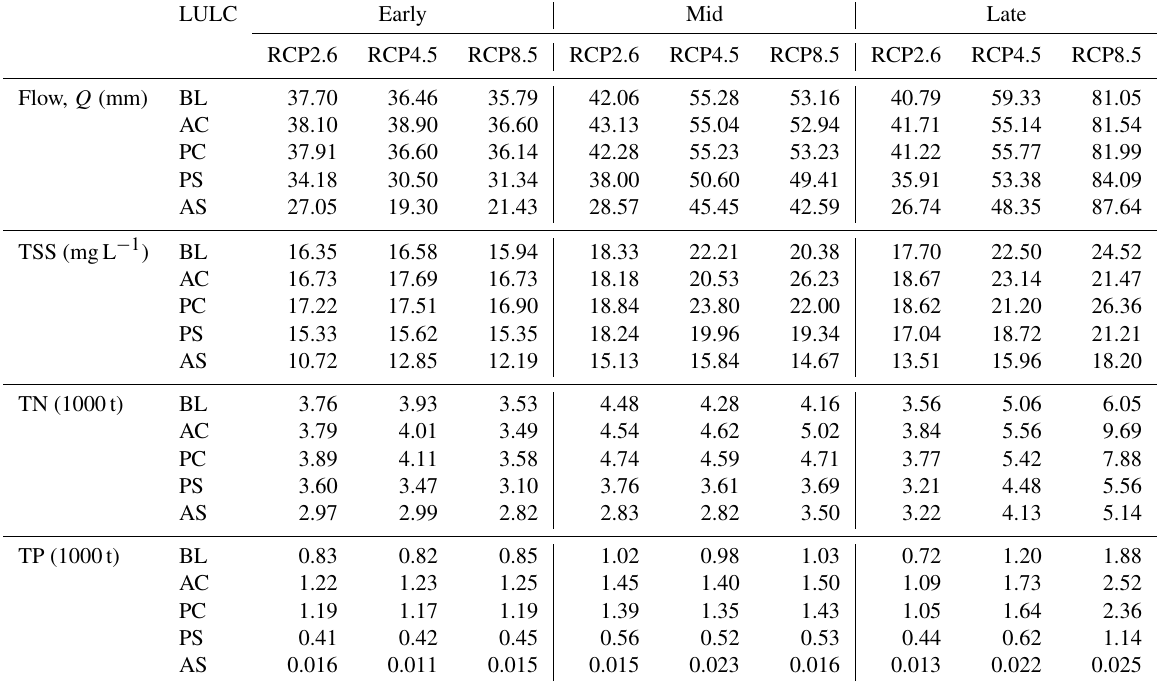
Table A1. Standard deviation of Q , TSS, TN and TP among 8 cli- mate models.